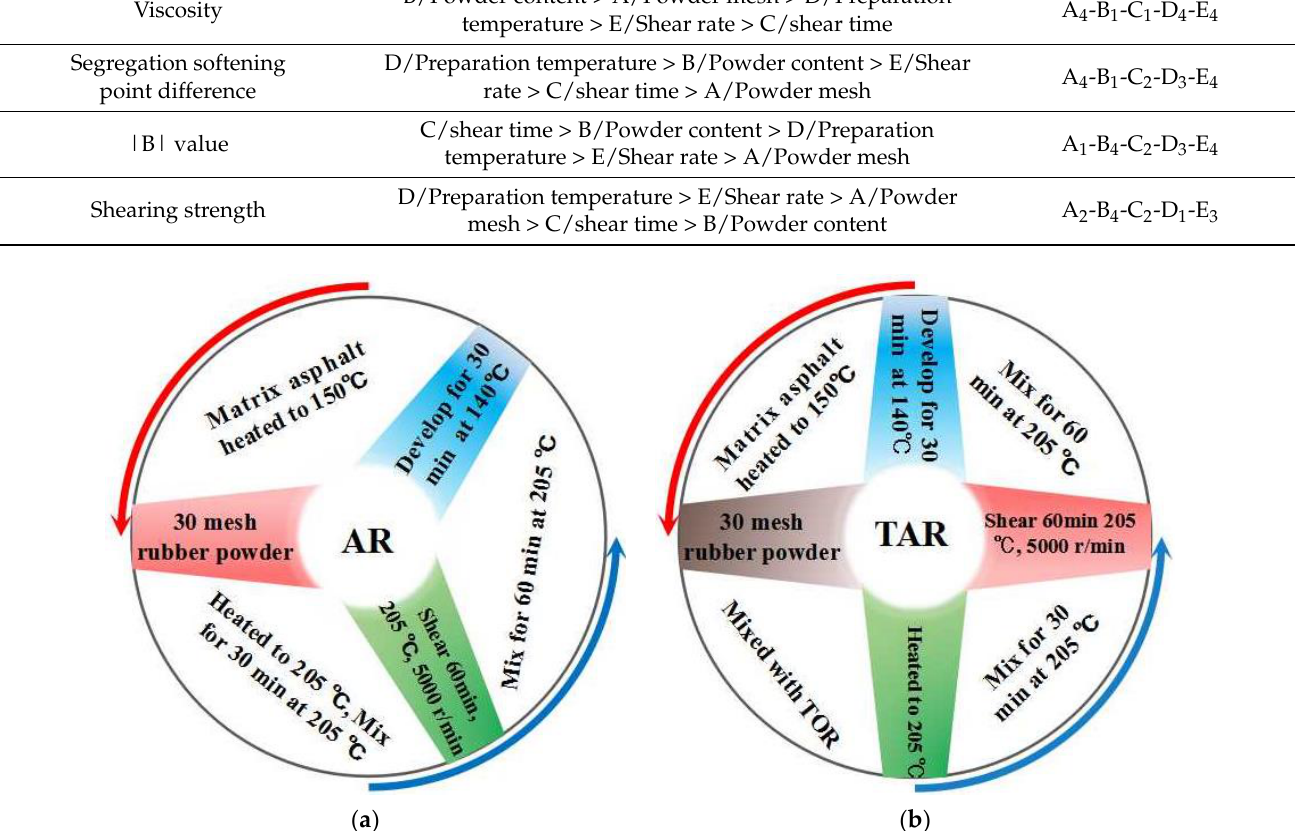
Figure 11. Flow charts of AR and TAR preparation process. ( a ) AR, ( b ) TAR.